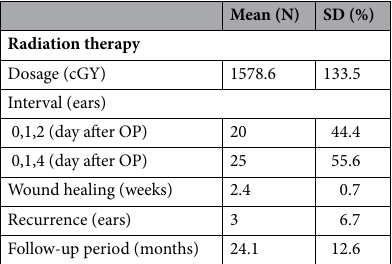
Table 2. Treatment outcomes of auricular keloids. N number, OP operation, SD standard deviation.